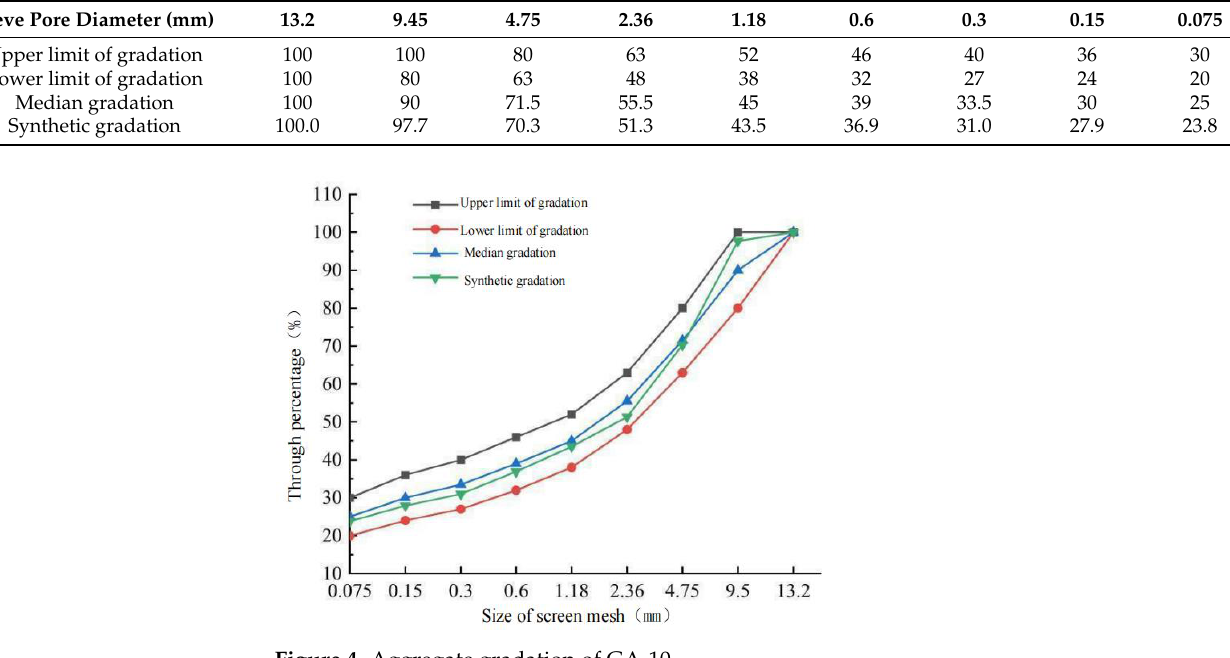
Figure 4. Aggregate gradation of